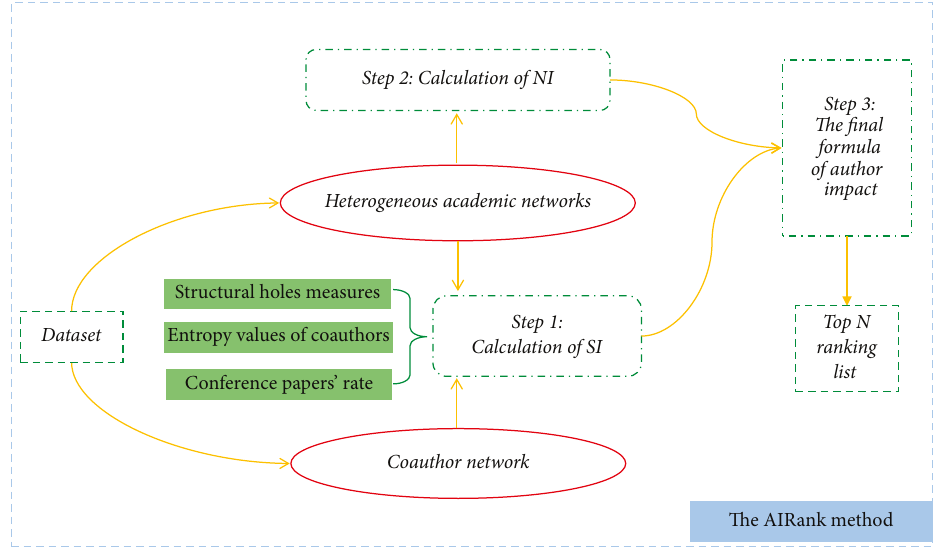
Figure 3: Architecture of